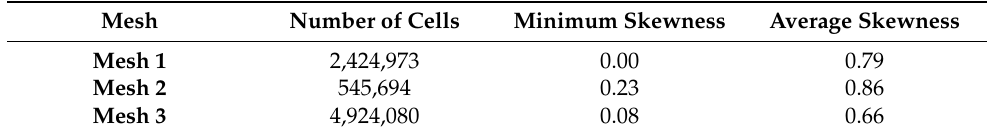
Figure 5. Histograms of skewness quality measures: ( a ) Mesh 1 generated from geometry 1; ( b ) Mesh 2 generated from geometry 2; ( c ) Mesh 3 generated from geometry 2. Table 4. Skewness quality measure